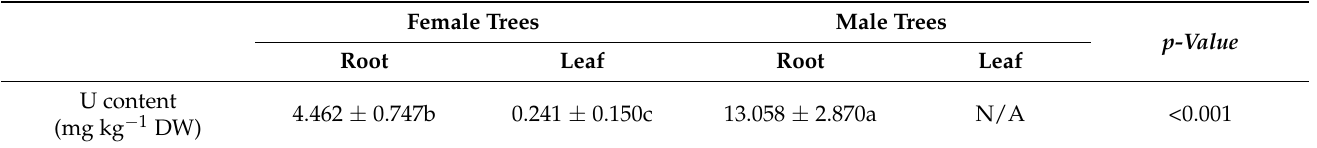
Table 1. Content of U accumulated in root and leaf of P. cathayana .